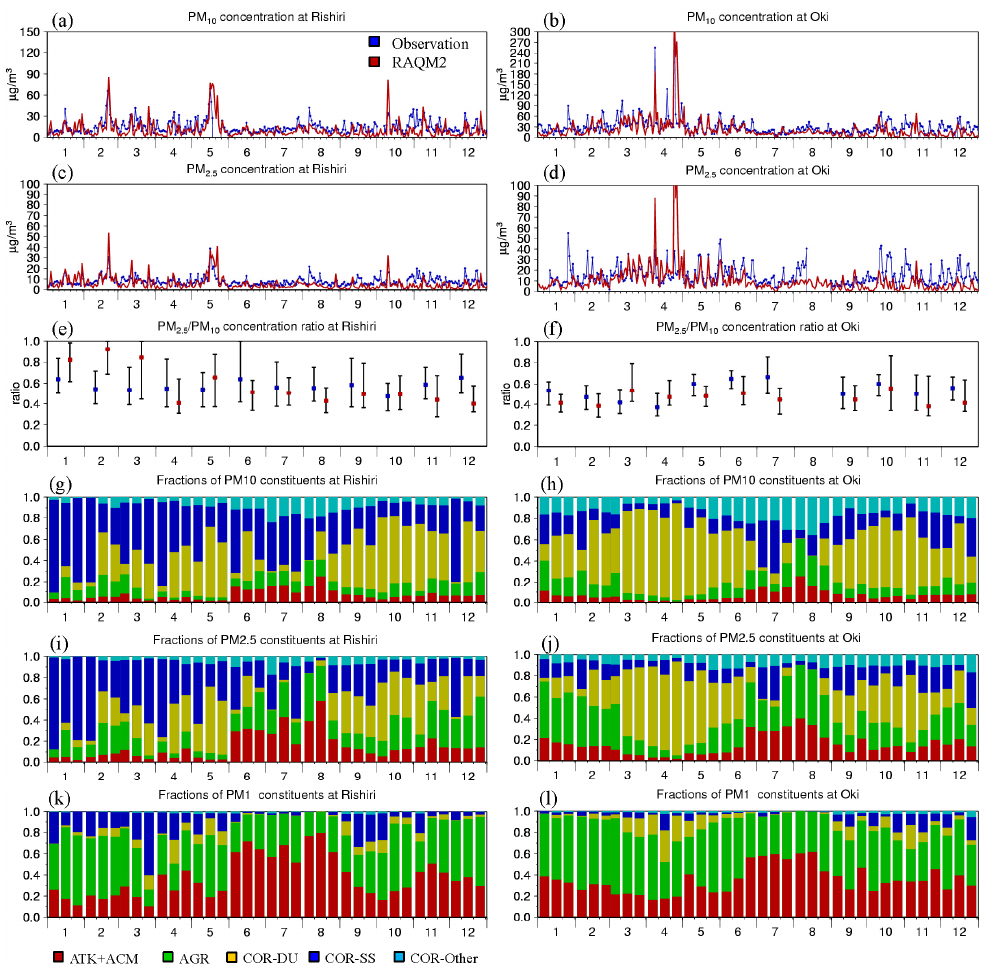
Figure 4. Daily mean observed (blue) and modeled (red) concentrations of (a)-(b) PM , (c)-2 Fig. 4. Daily mean observed (blue) and modeled (red) concentrations of (a–b) PM 10 , (c–d) PM 2 . 5 , (e–f) PM 2 . 5 /PM 10 concentration ratios 10 (the median with 75 and 25 percentile values) and modeled constituent fractions of (g–h) PM 10 , (i–j) PM 2 . 5 , and (k–l) PM 1 concentrations (d) PM , (e)-(f) PM /PM concentration ratios (the median with 75 and 25 percentile 3 2.5 2.5 10 at (left) Rishiri and (right) Oki. Among the constituents, ATK + ACM (red) is the total dry mass (SO 2 − , NH + , NO − , Cl − , UID and OA) 4 4 3 values) and modeled constituent fractions of (g)-(h) PM , (i)-(j) PM , and (k)-(l) PM 4 of the ATK and ACM categories, AGR (green) is the total dry mass (UID, BC, OA, SO 2 − , NH + , NO − , and Cl − ) of the AGR category, 10 2.5 1 4 4 3 COR-DU (yellow) is the dust mass (DU) of the COR category, COR-SS (blue) is the sea-salt mass (SS + Cl − ) in the COR category and concentrations at (left) Rishiri and (right) Oki. Among the constituents, ATK+ACM (red) is 5 ) in the COR category. COR-Other (sky blue) includes the other components (UID, BC, OA, SO 2 − , NH + , and NO − 4 4 3 provide additional important implications for modeling stud-